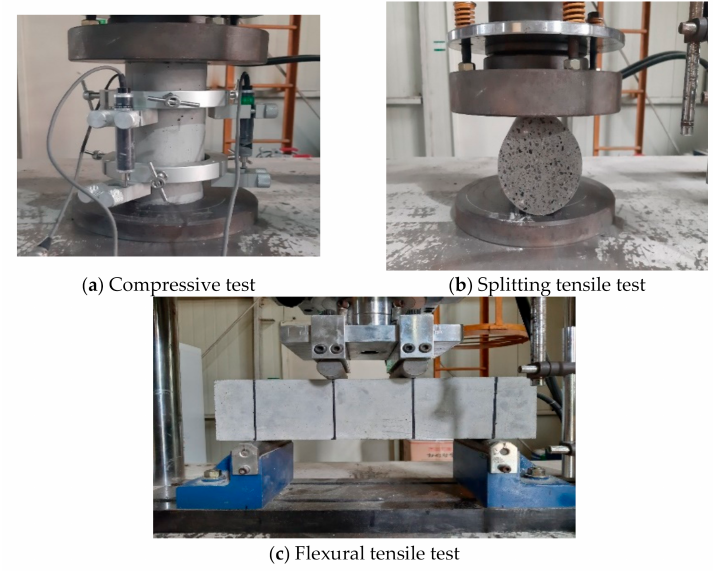
Figure 3. Material test setup.